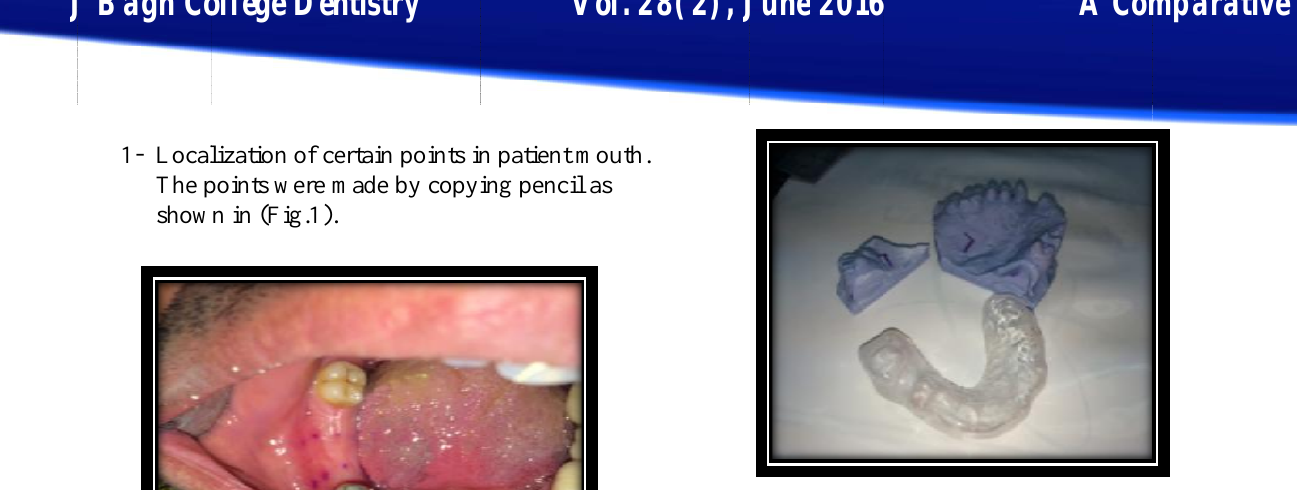
Fig. Fig. 3: Ridge (bone) mapping on the cast. 3: Ridge (bone) mapping on the cast. 6- The exact drilling point was placed on the The exact drilling point was placed on the surgical stent depending on the resulted ridge surgical stent depending on the resulted ridge which which represented the direct bone without the covering keratinized tissue covering keratinized tissue Surgical procedure Surgical procedure groups implanted. implanted. For flapped (control) group, flap design was